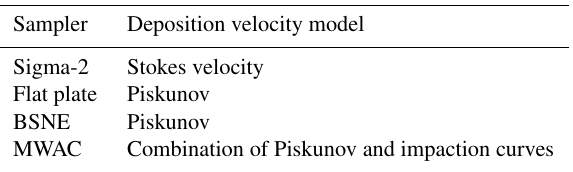
Figure 2. Deposition velocities for single particles to a smooth sur- face (flat-plate sampler) calculated by using a set of different clas- sical deposition models for the Tenerife samples (9 August 2017; average wind speed of 3.0ms − 1 ). Table 1. A summary of different deposition velocity models applied to the